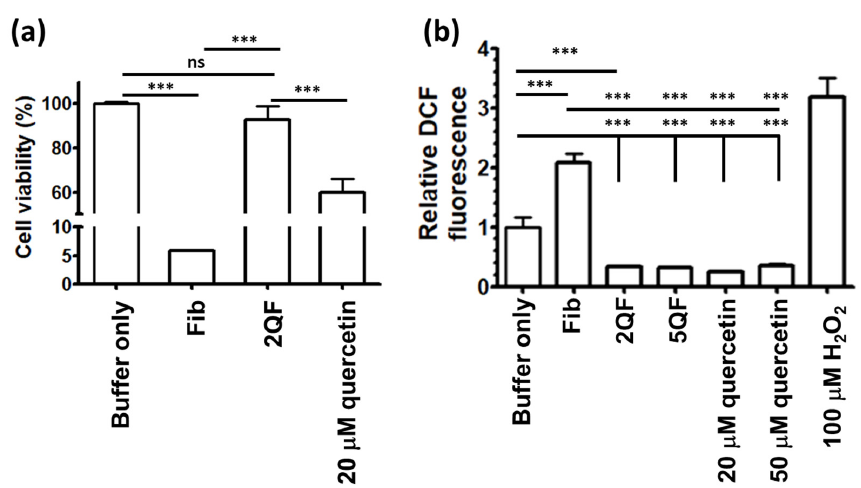
Figure 5. ( a ) Viability of neuroblastoma (N2a) cells treated with buffer (control), Fib, 2QF, and 20 µM quercetin. ( b ) ROS level of N2a cells after treatment with fibrils (Fib, 2QF, or 5QF) or quercetin (20 or 50 µM) determined by intracellular DCF assay. The statistical significance is represented by asterisk (ns, not significant; ***, p < 0.001).